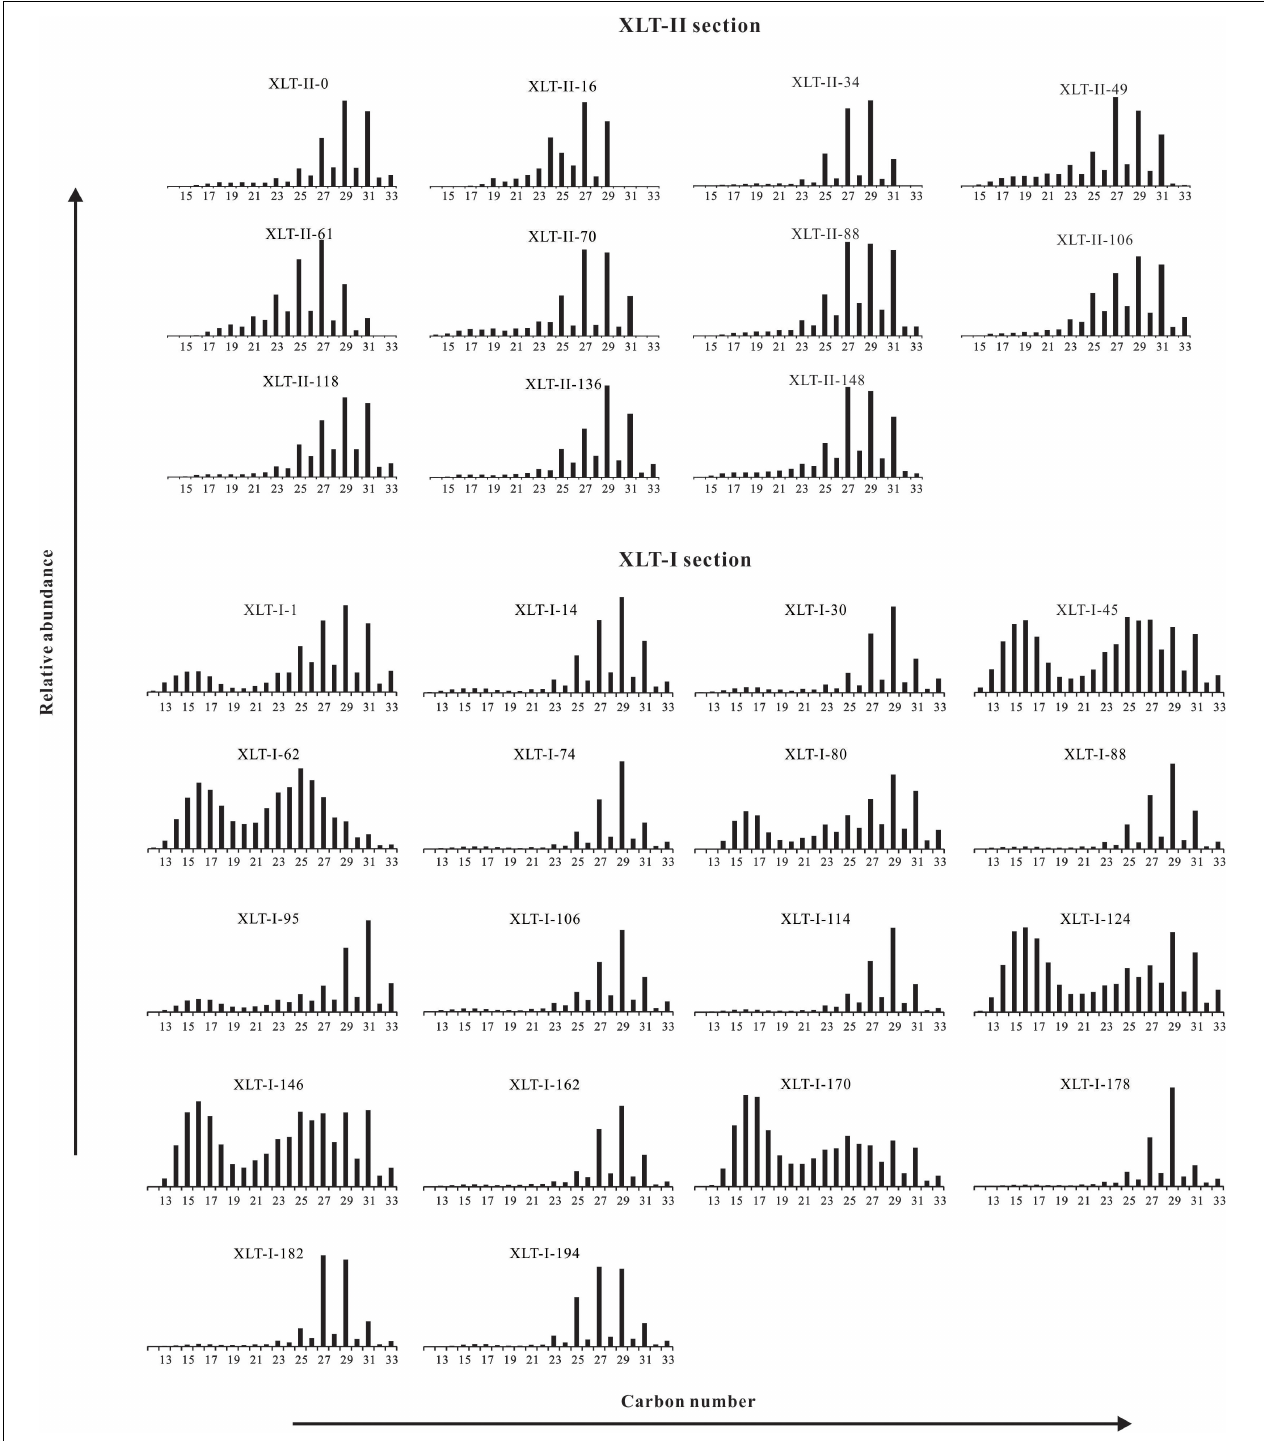
FIGURE 3 | Distribution patterns of n -alkanes of representative sediments from XLT-I and XLT-II sections.